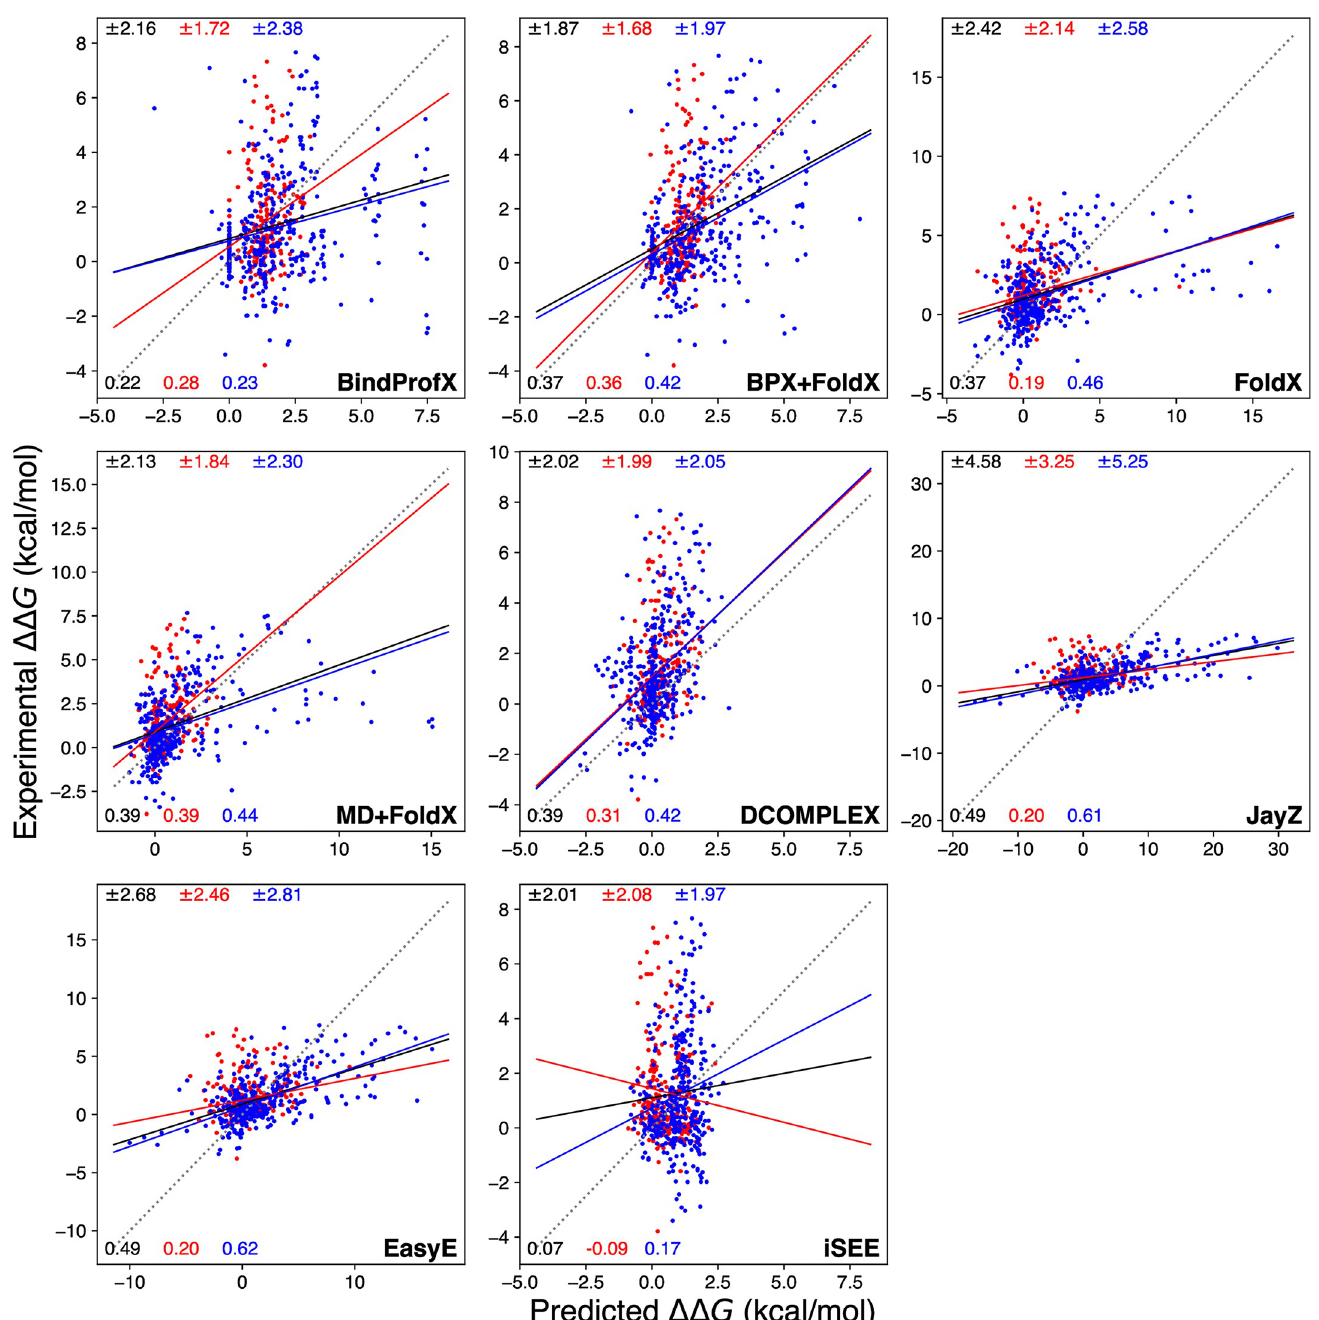
Fig 1. Calculated ΔΔ G values (x-axis) compared to experimental ΔΔ G values (y-axis) for each method tested in this study. Black, red, and blue lines are simple linear regressions from which r are derived. The red points are a scatter for Ab complexes and the blue points are for non-Ab complexes. The dashed line is the y = x line measuring perfect agreement between predicted and experimental ΔΔ G values. The solid black, red, and blue lines indicate a linear relationship between calculated and experimental observations for all data points, Ab complexes, and non-Ab complexes respectively. The top values in black, red, and blue match the root-mean-square error and the bottom values indicate r for all values, Ab values, and non-Ab values respectively. method. EasyE has the highest r for non-Ab for five out of eight subsets (wild type non-gly or non-pro, alpha helix, beta sheet, surface exposure, and large volume changes). Where this method did not have the highest r , it had either the second or third highest r . JayZ mirrors the